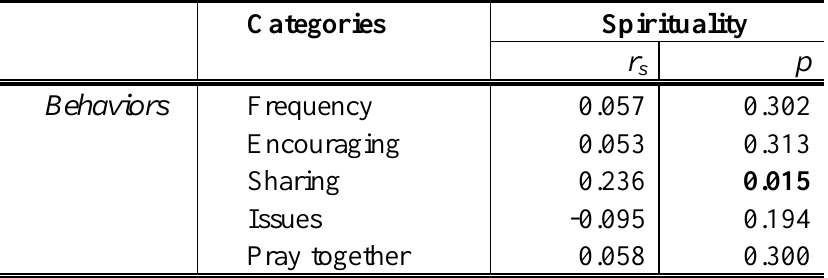
Table 5. Correlation between staff‟s behaviors and